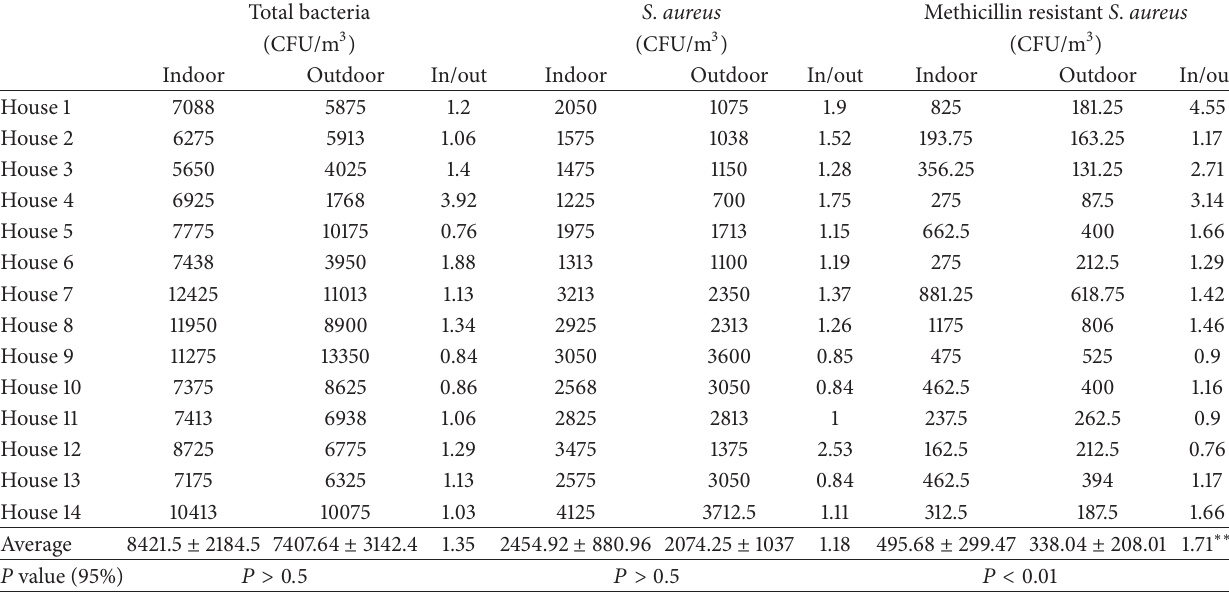
Table 1: Bacterial concentrations from inside and outside of residential houses at Gwalior. Total